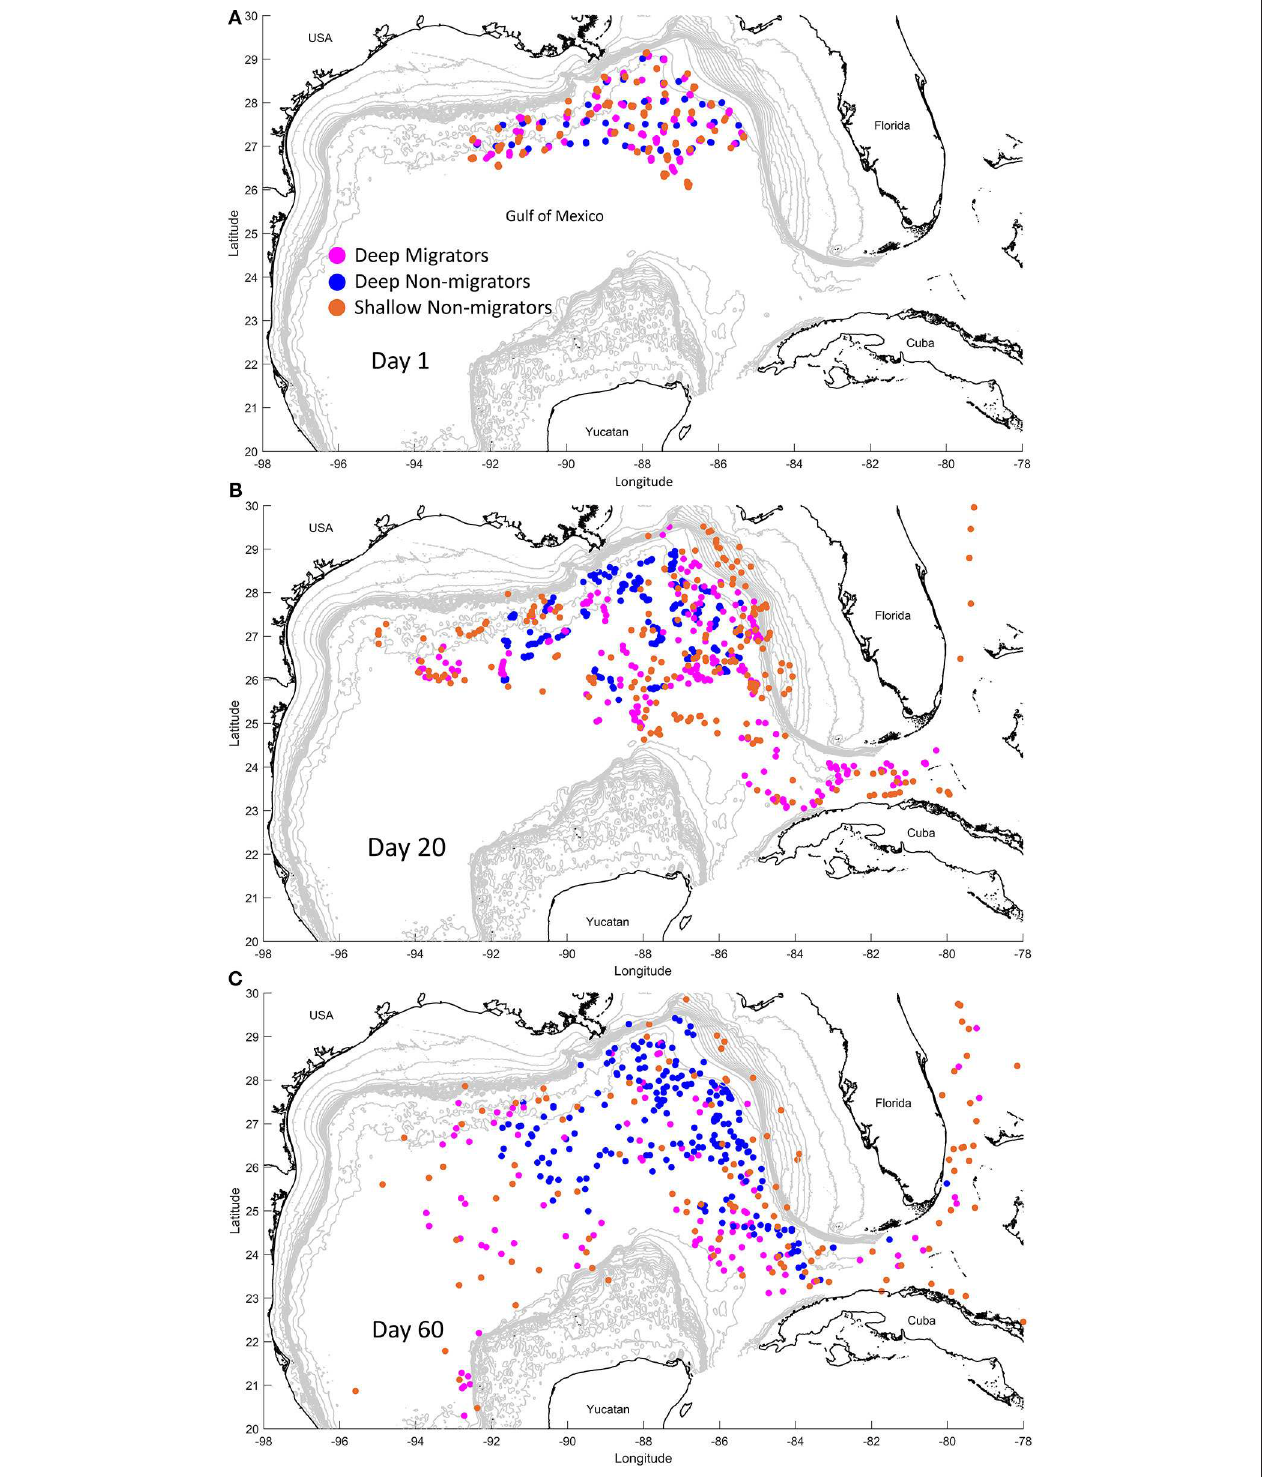
FIGURE 3 | Snapshots of the biophysical modeling simulation at day 1 (A) , day 20 (B) , and day 60 (C) . Particles that exhibit diel vertical migration (“Migrators”) from 900m to 200m are in pink. Particles that do not exhibit this behavior, instead residing at 900m (blue, “Deep Non-migrators”) or 100m (orange, “Shallow Non-migrators”), are also